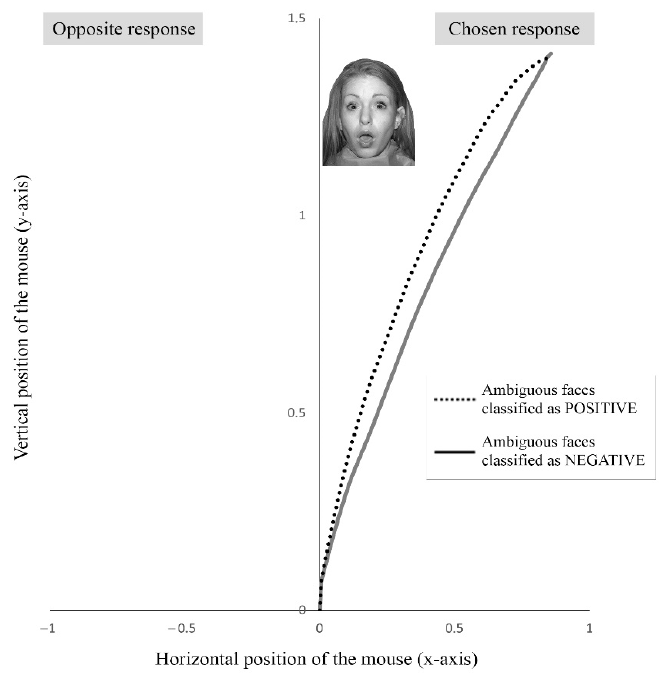
Figure 2. Mouse trajectory when classifying ambiguous faces as negative or positive. There was a greater maximum deviation of the mouse when classifying ambiguous faces as “positive” than “negative”. When participants classified ambiguous faces as “positive”, they showed response trajectories that indicated a greater attraction towards the competitive option (negative), as opposed to when they classified an ambiguous face as “negative”, which they did more